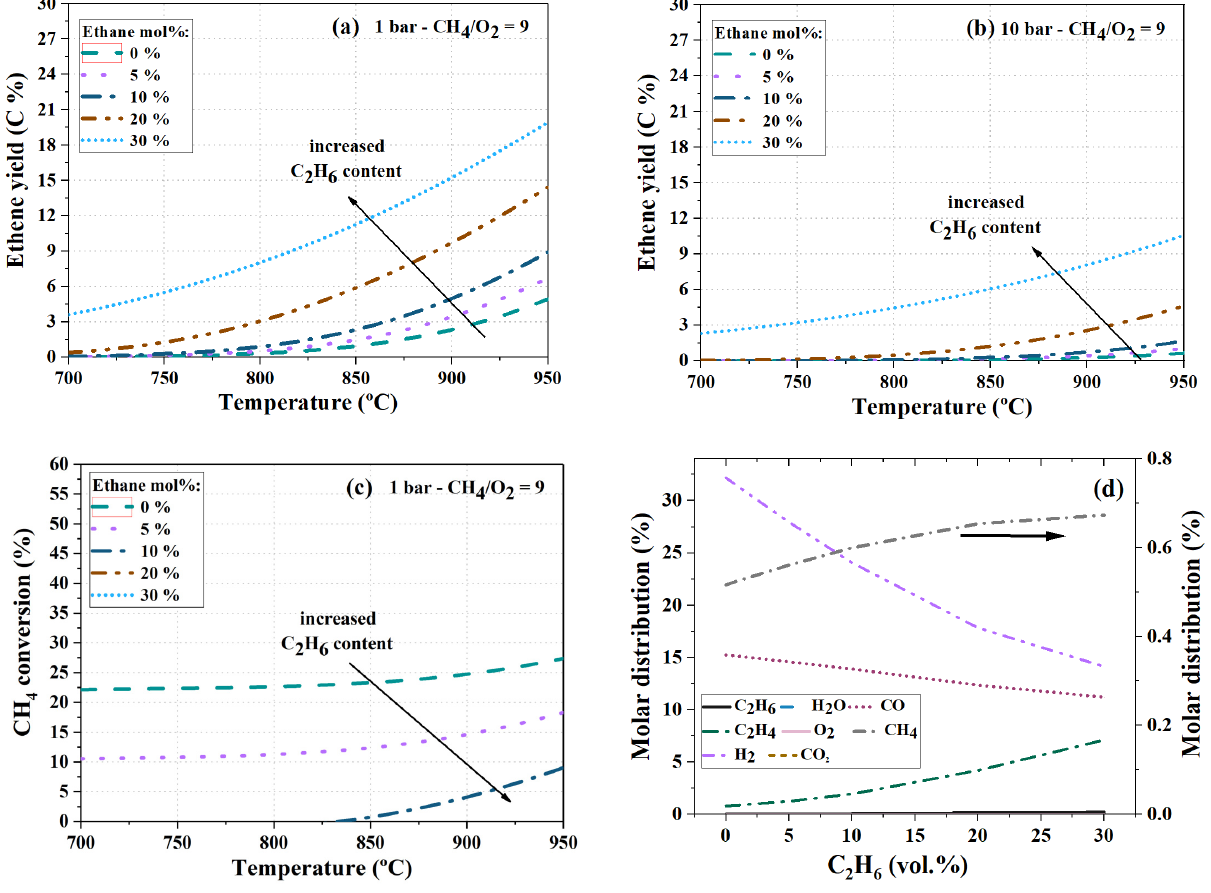
Figure 25. Effect of co-feeding C 2 H 6 on: ( a , b ) carbon-based C 2 H 4 yield as a function of temperature at the CH 4 /O 2 feed molar ratio equal to 9 and pressure of 1 ( a ) and 10 ( b ) bar; ( c ) CH 4 conversion as a function of temperature at the CH 4 /O 2 molar feed ratio equal to 9 and pressure of 1 bar; and ( d ) equilibrium molar distribution as a function of C 2 H 6 feed composition at 900 ◦ C, 1 bar and CH 4 /O 2 molar feed ratio equal to 9. C 2 H 6 composition in the feed was varied while keeping the total number of mols and the CH 4 /O 2 feed molar ratio constant. C 2 H 4 yield was calculated considering both CH 4 and C 2 H 6 in the feed (see Equation (A5) in the Supplementary Materials).